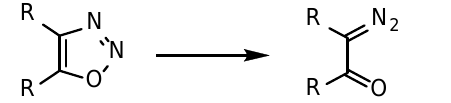
Figure 3. Acyldiazomethane tautomer [21].